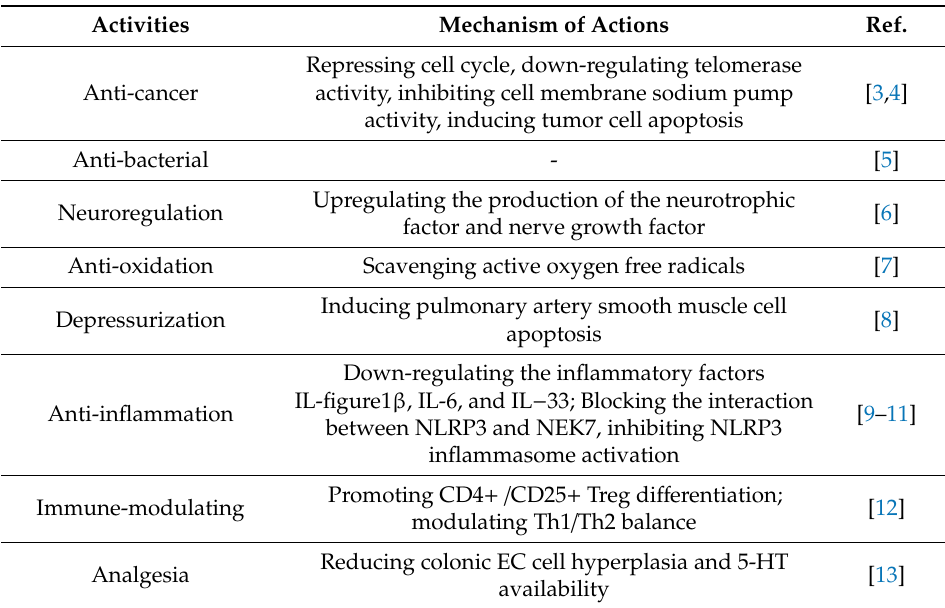
Figure 1. Molecular structure and typical modification sites of Oridonin (ORI). Table 1. Pharmacological activities of ORI.